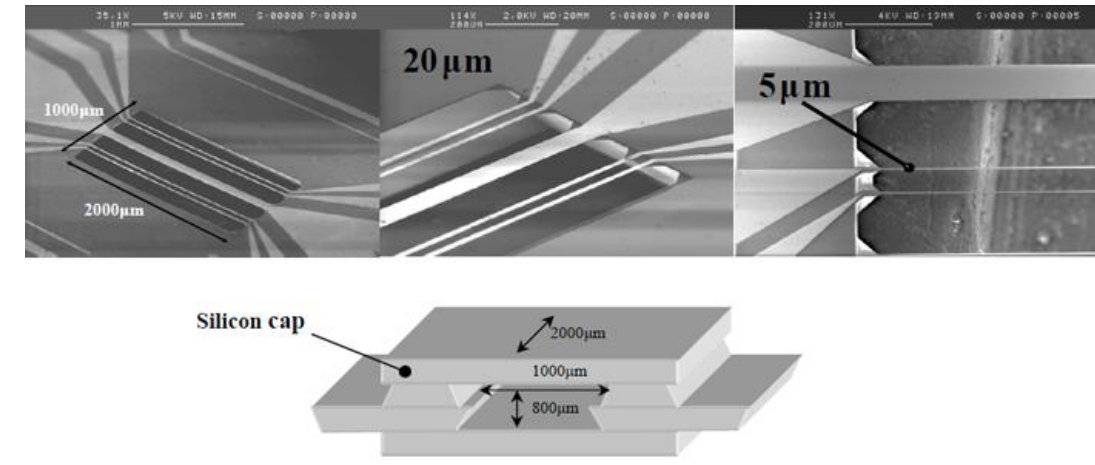
Figure 2. SEM images of the sensor: Global view and view of different detector widths, on top. Cavity scheme,